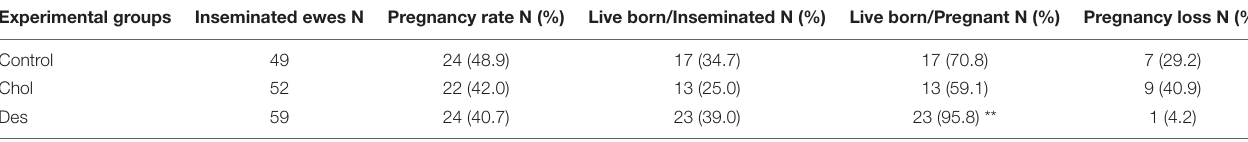
TABLE 2 | In vivo fertility of frozen-thawed ram sperm pretreated with 10 mM M β CD-Chol (Chol) or 10 mM M β CD-Des (Des) after cervical